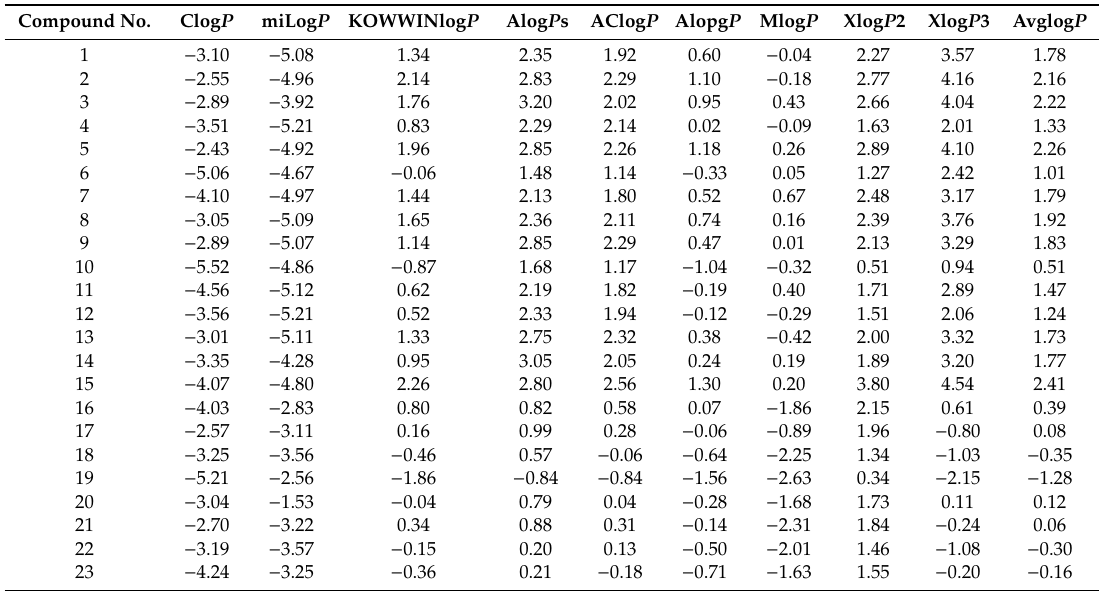
Table 1. Calculated log P values for investigated compounds. Compound No.